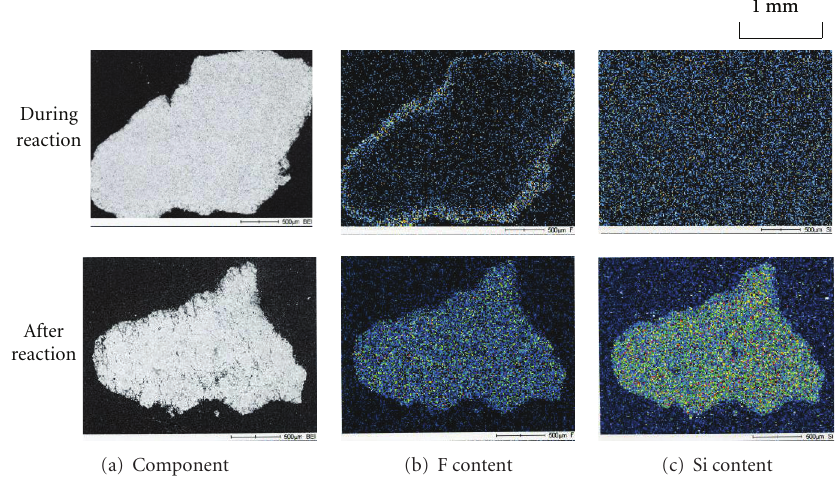
Figure 13: EPMA photographs of the NaHCO 3 adsorbents before and after